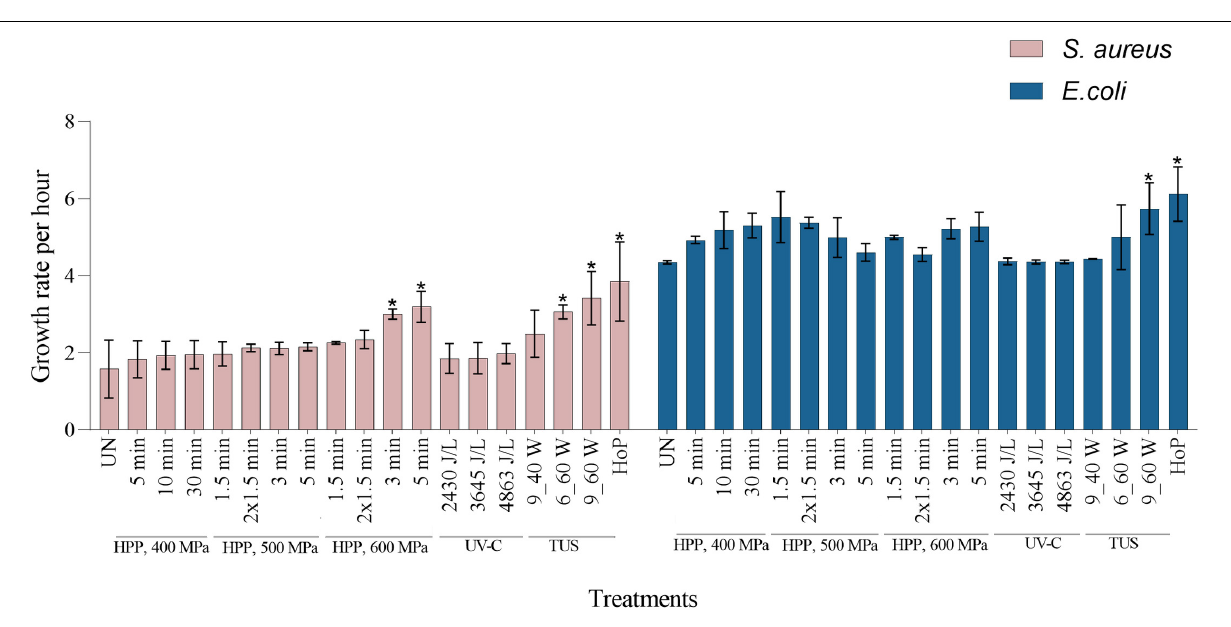
FIGURE 6 | Growth rate per hour of S. aureus and E. coli in untreated, HPP, UV-C, TUS, and HoP DHM samples. The results are presented as mean ± standard deviation of two independent experiments and all analyses were performed in technical duplicate. UN represents the untreated values. *Indicates significant differences to untreated samples ( p <